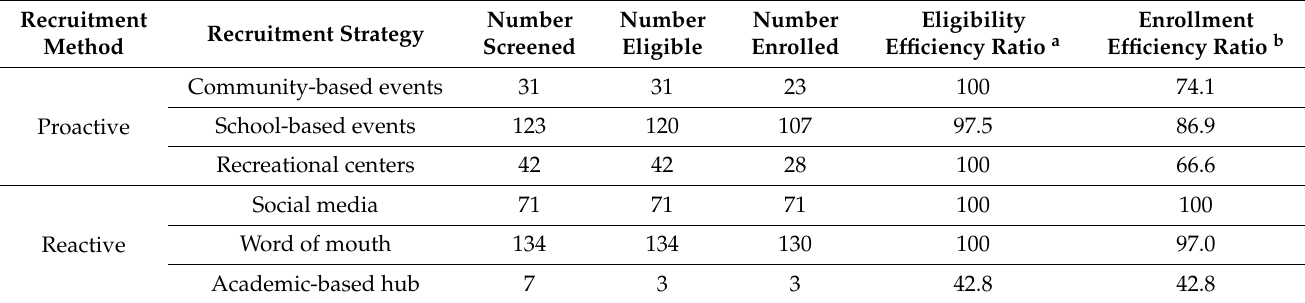
Table 2. Recruitment efficiency of specific recruitment